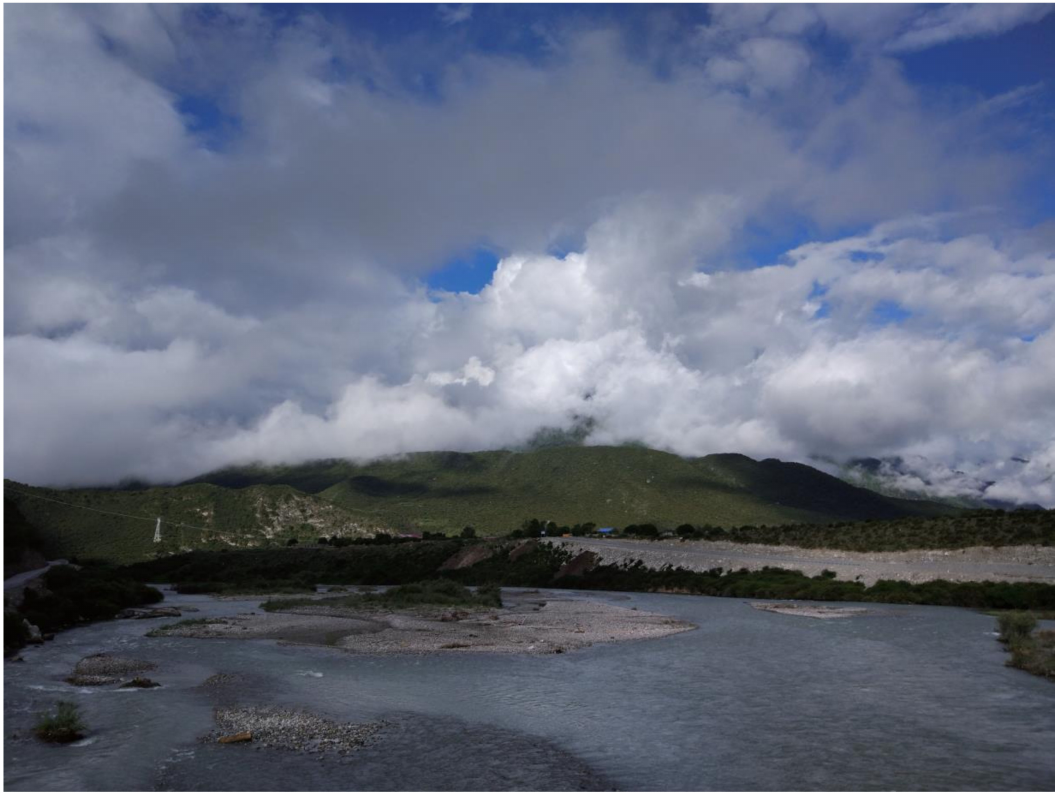
Figure 1. General view of melt ponds (top) and periglacial rivers (bottom) in the Zhuxi